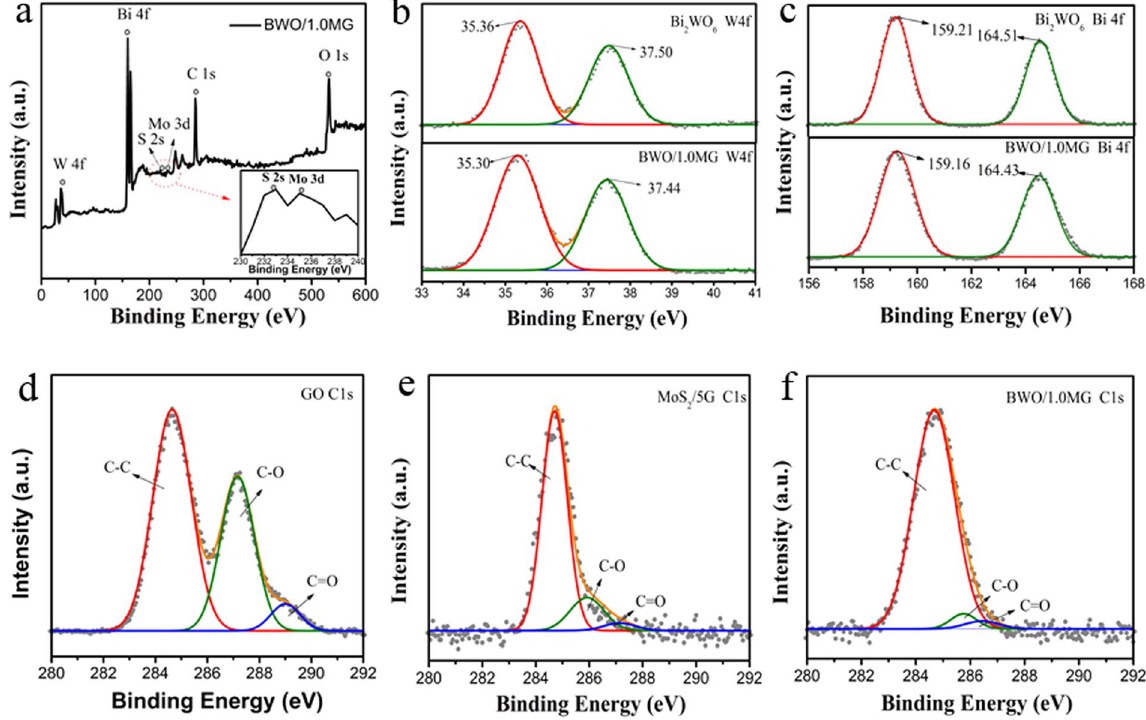
Figure 2. XPS spectra of ( a ) BWO/MG (inset shows a high resolution Mo 3d and S 2 s spectrums in MoS 2 ), ( b ) W 4 f and ( c ) Bi 4 f; ( d ) C 1 s spectra of BWO, ( e ) MG and ( f )